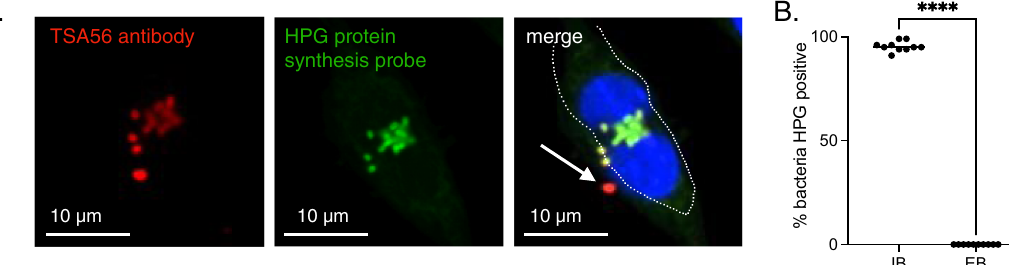
Fig. 2 Intracellular and extracellular forms of Ot are metabolically distinct. A Confocal microscopy image of an L929 cell infected with Ot for 5 days and labeled with the clickable methionine analog homopropargylglycine (HPG, green) and an antibody against surface protein TSA56 (red). DNA (Hoechst) is shown in blue. The host cell outline is showed by a dashed line, and an arrow indicates a metabolically inactive bacterium located outside the host cell. B Quanti fi cation of metabolic activity, as measured by a detectable HPG signal, in IB and EB Ot. L929 cells were infected with Ot for 5 days, fi xed, and labeled with TSA56 and HPG. Bacteria were identi fi ed as being IB or EB, based their position relative to host cells, and the percentage of each population that was HPG-positive was quanti fi ed. The percentage positivity for ten randomly imaged fi eld is shown here, and this data is representative of >3 independent repeats of this experiment. Groups were compared using a two-sided Mann – Whitney test. Statistical signi fi cance for all data in this fi gure was determined using Graphpad Prism software. * p value ≤ 0.05, ** p value ≤ 0.01, *** p value ≤ 0.001, **** p value ≤ 0.0001, ns not signi fi